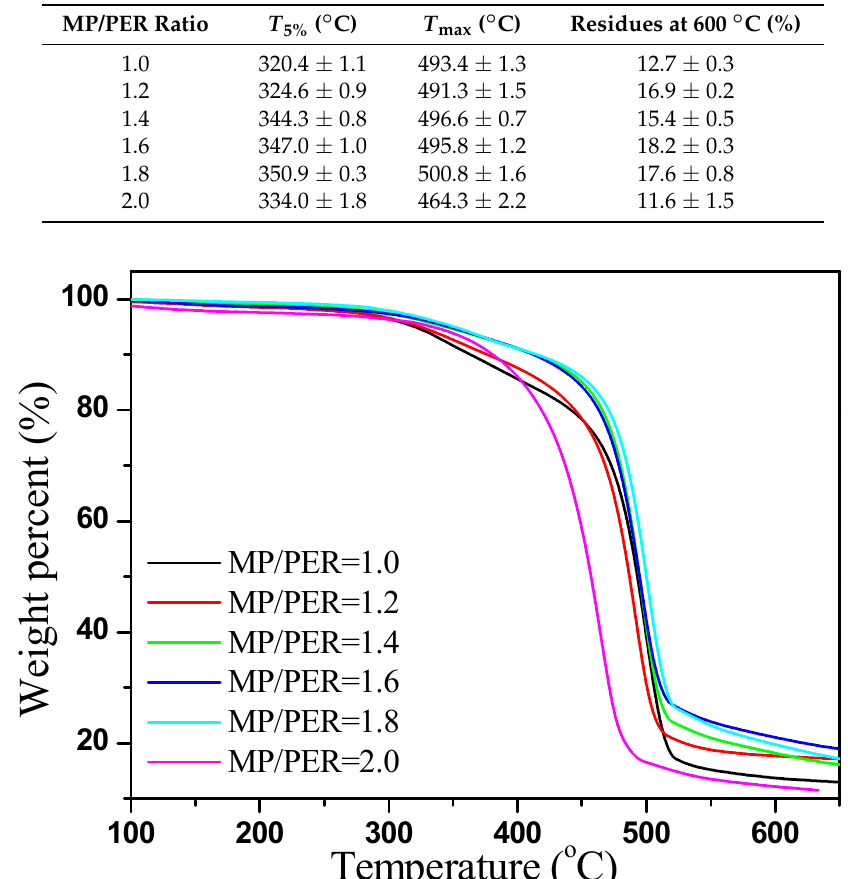
Figure 4. TGA curves of reactive MP/PER masterbatches with different molar ratios.